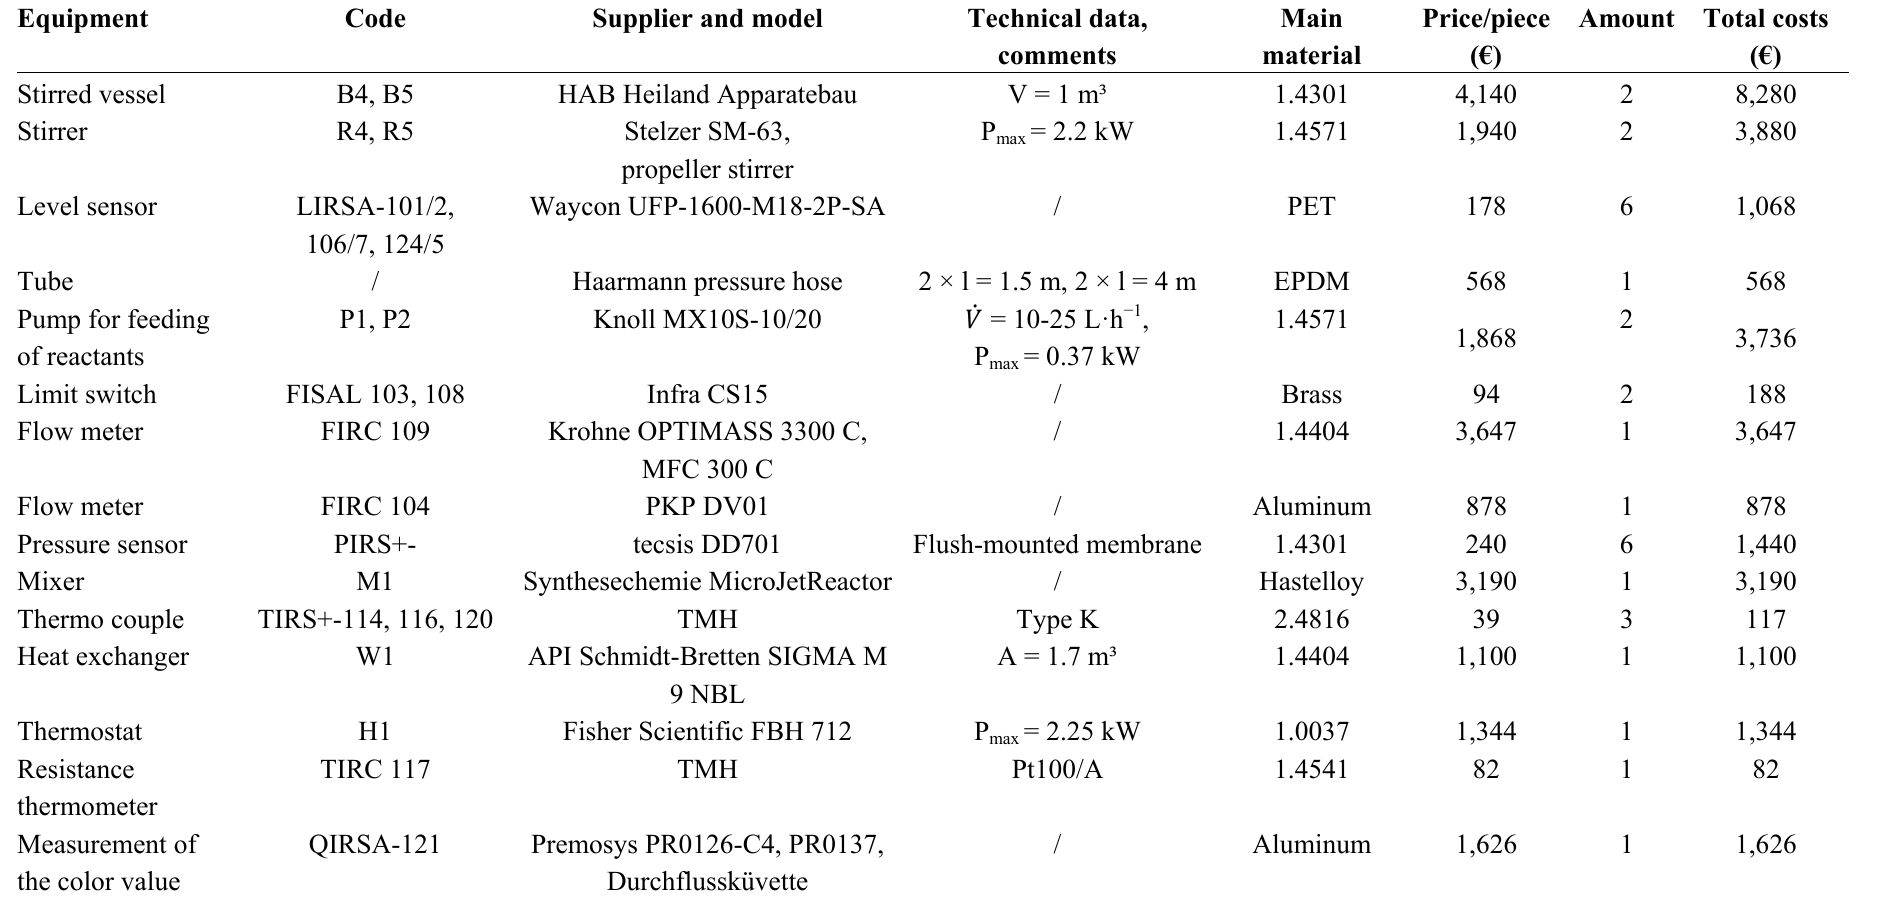
Table B-2. Equipment list and costs for the micro-/milli-continuous campaign